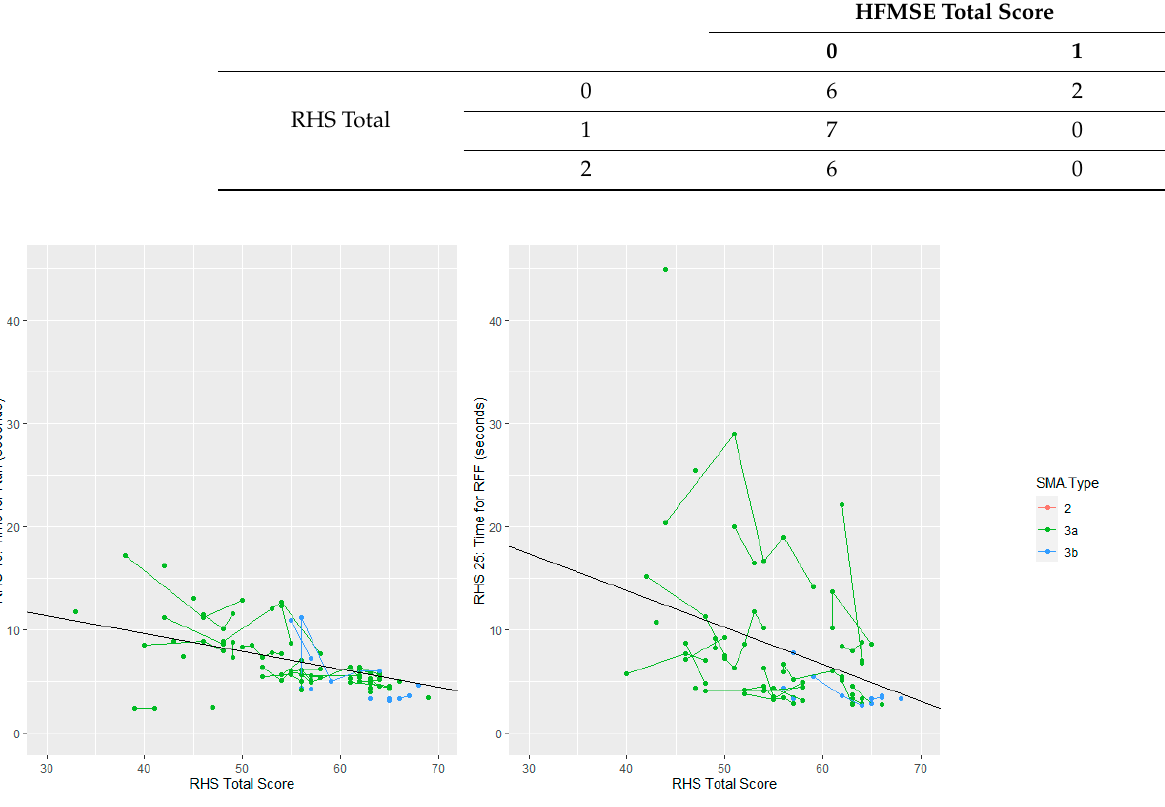
Figure 1. Trend in RHS Timed tests by RHS total score, with overlayed mean line. Lines connect the same patients over multiple time points.